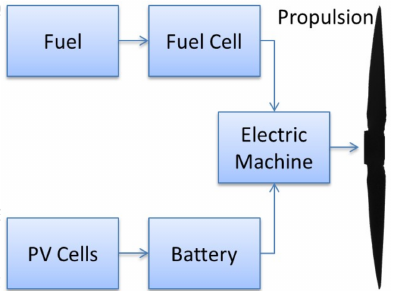
Figure 8. Configuration of a potential fuel-cell + photovoltaic (PV) + battery hybrid system. In this example, the PV system is in series with a battery system, which are both in parallel with a fuel-cell